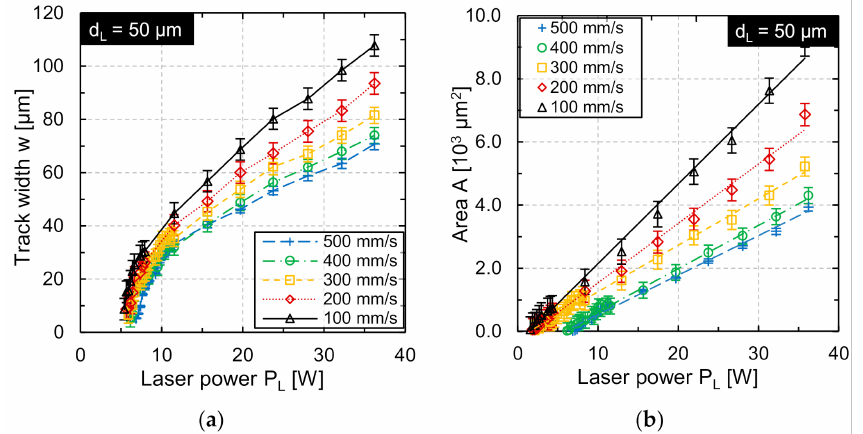
Figure 4. ( a ) Width of the remelted track as function of laser power and scan speed; ( b ) magnification for laser power P L = 8–12 W; and ( c ) squared track width as function of laser power ( d L = 50 µ